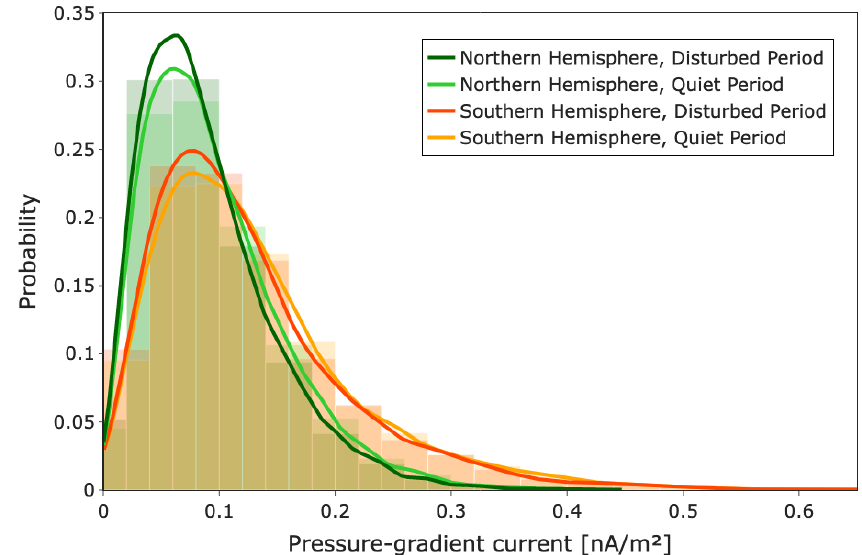
Figure 5. Distributions of the pressure-gradient current values for disturbed and quiet geomagnetic activity conditions for the Northern and Southern hemispheres. Solid line represents the continuous probability density curve and it is plotted above the more transparent relative